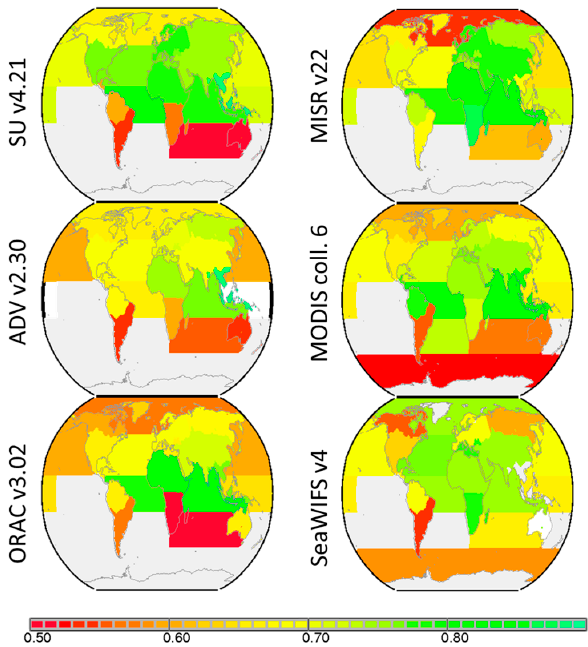
Figure 7. Total regional skill score from AOD evaluation for the three AATSR retrievals and three NASA AOD retrievals for the year 2008. AATSR versions ( left column), MISR, MODIS and SeaWiFS data ( right column). Better scores are in green and poorer scores are in red. Differences in regional coverage are related to retrieval area coverage and retrieval frequency. Table 7. AOD evaluation scores for 3 AATSR algorithms and 3 NASA AOD retrievals over land and ocean based on daily L3 matches to AERONET data for the year 2008.